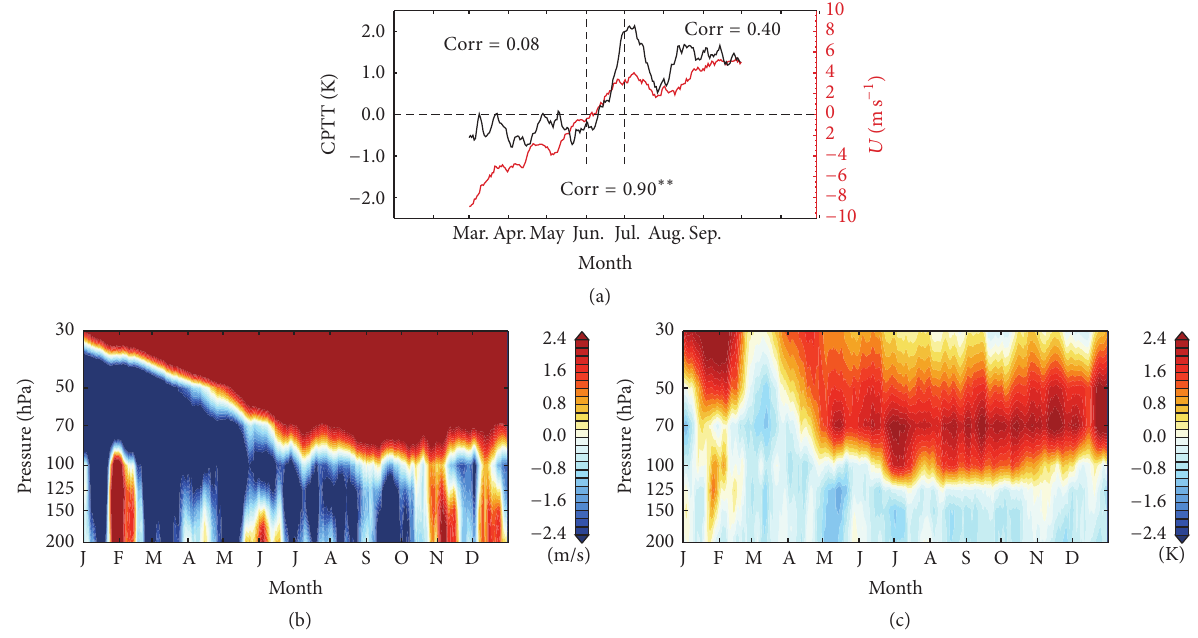
Figure 6: (a) Same as Figure 3(b) but for CPTT and 10 ∘ N–10 ∘ S averaged 70 hPa zonal wind. Time-pressure cross sections of (b) zonal wind and (c) temperature daily anomalies in 1999. “ ∗∗ ” denotes that the correlation coefficients exceed the significance test at the 95% confidence